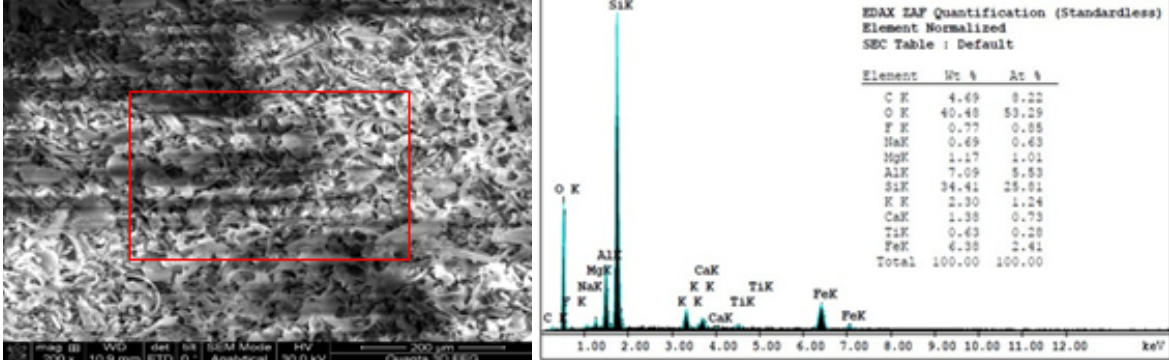
Figure 5 : SEM-EDX spectrum of raw